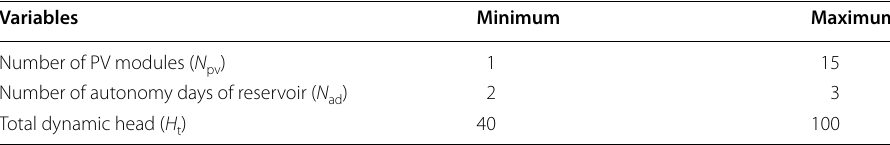
Table 4 Minimum and maximum values of variables to optimize